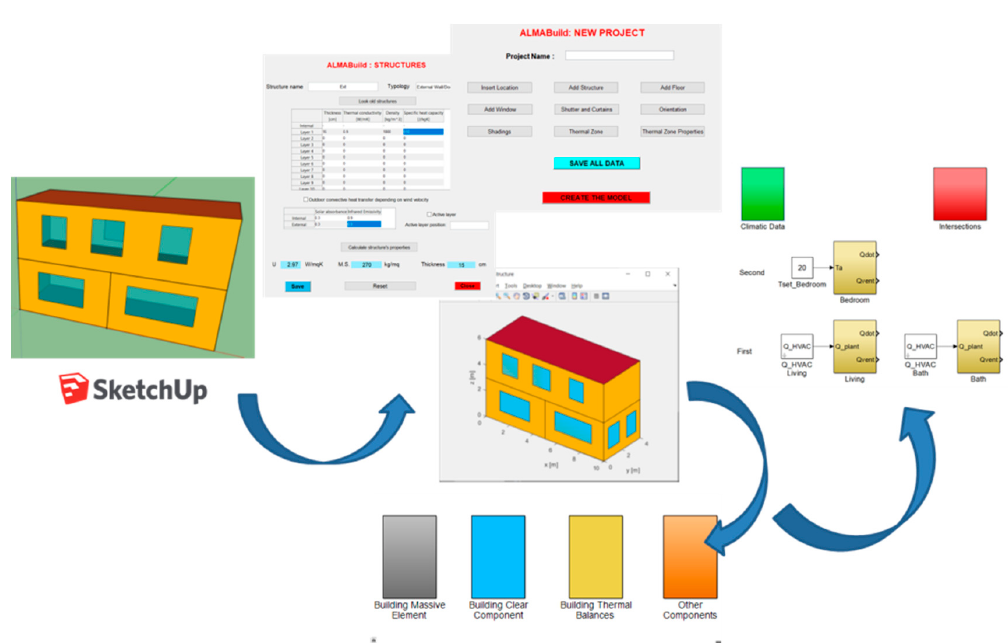
Figure 2. Schematic representation of the ALMABuild rationale: by means of a series of GUI interfaces the SIMULINK model is automatically created.